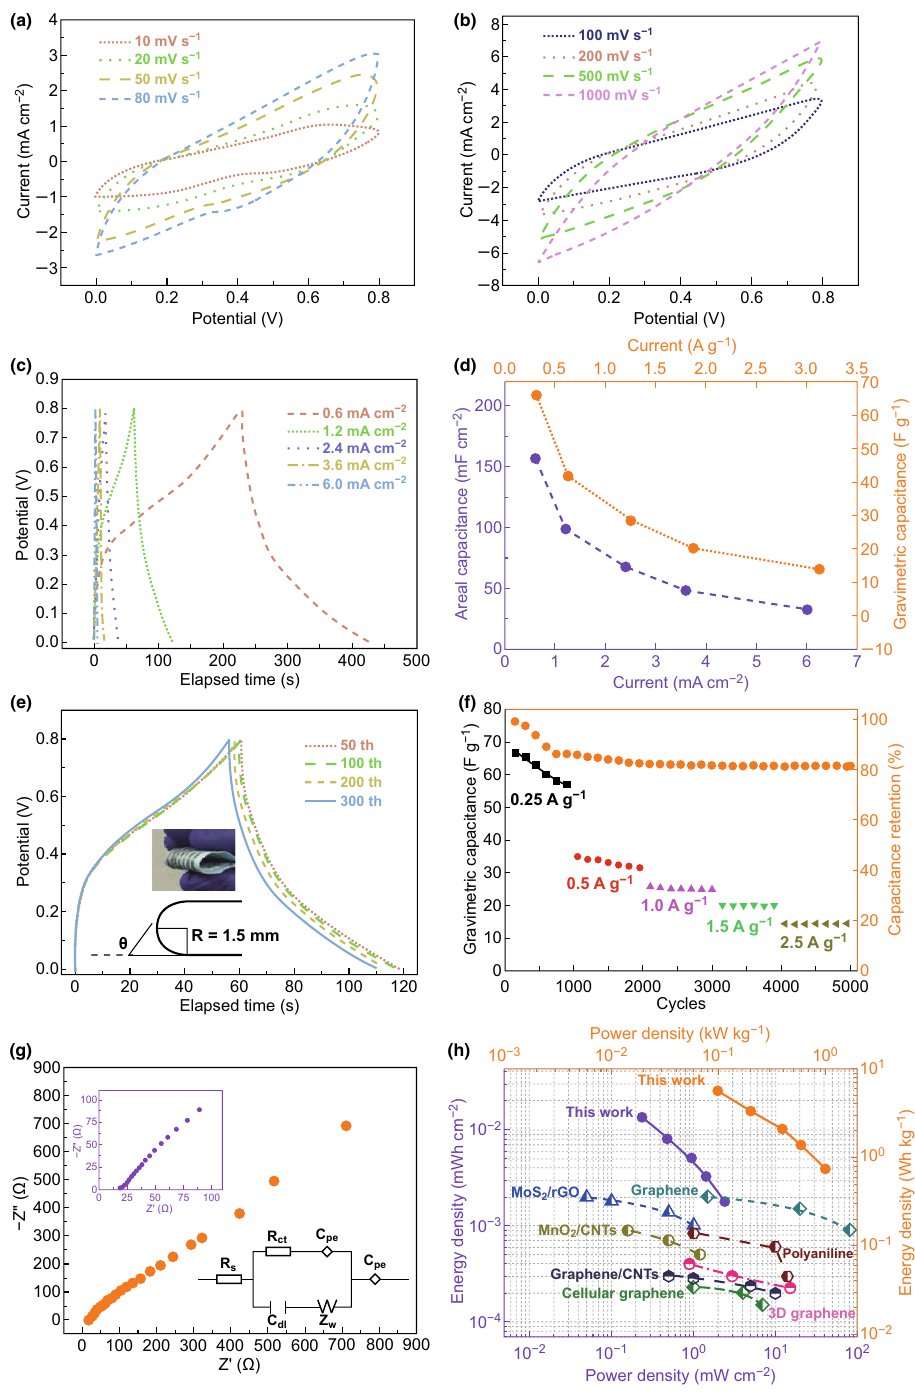
Fig. 5 a CV curves of a CoP@Ni NTAs@SE-based SC at different low scanning voltage rates. b CV curves at different high scanning voltage rates. c GCD curves of a CoP@Ni NTAs@SE-based SC at different areal current densities. d Area and gravimetric capacitances at different current densities. e GCD curves of SC bent different times at 1.2 mA cm −2 . f Cyclic stability within 5,000 times at different current densities. g Nyquist plots of the CoP@Ni NTAs@SE SC. h Ragone plot of the CoP@Ni NTAs@SE